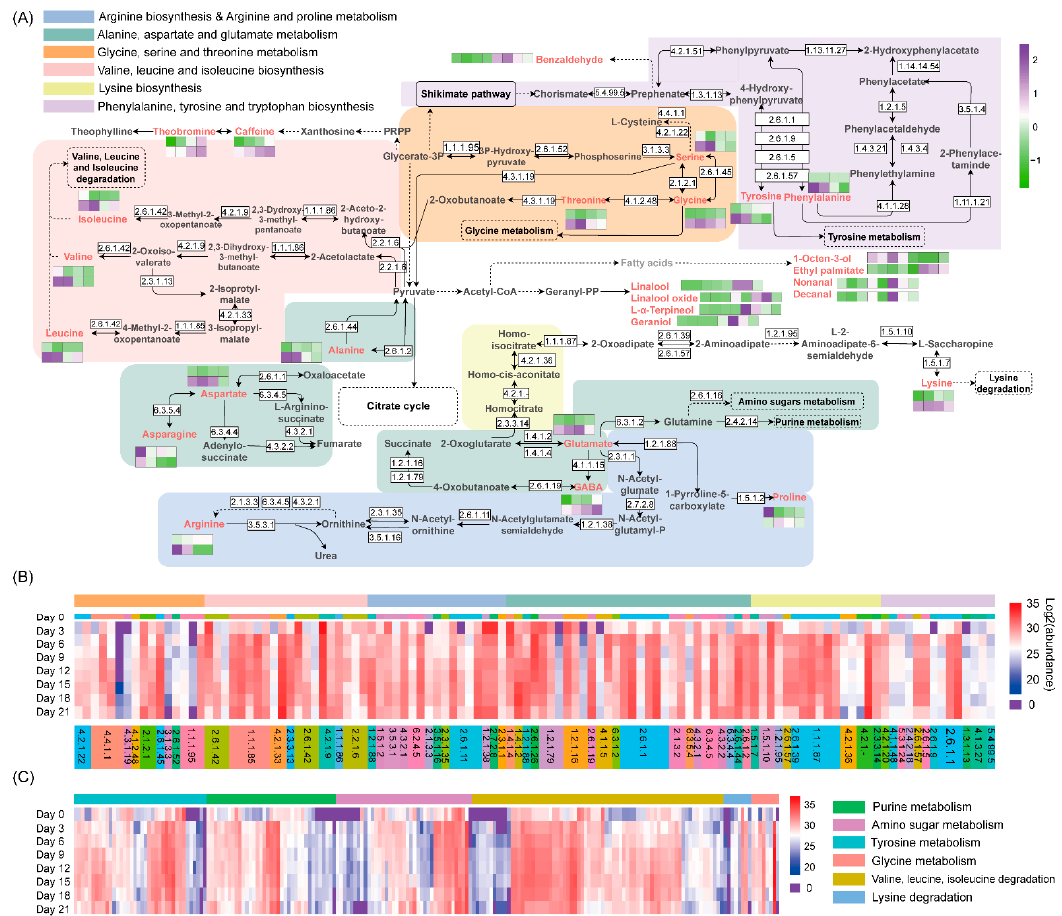
Figure 6. The map of the metabolic pathway based on differential metabolites ( A ), and the heatmap analysis of enzymes related to the biosynthesis and metabolism of metabolites ( B , C ). GABA, γ -aminobutyric acid.